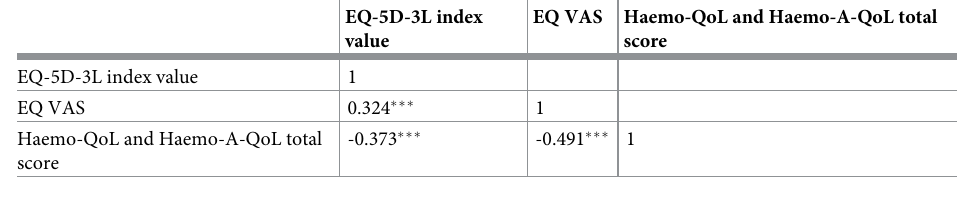
Table 3. Pearson correlations amongst